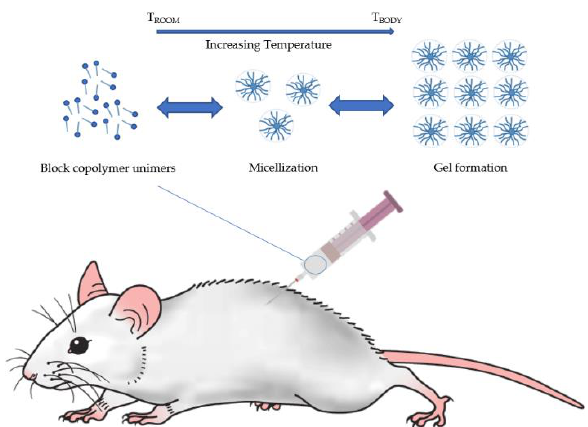
Figure 2. Schematic illustration of the in situ gelation mechanism of a thermo-responsive P407 aqueous solution. Upon a temperature rise, a breakage of the hydrogen bond is established between the aqueous solvent and the copolymer hydrophilic chains. Desolvation induces the hydrophobic interaction among the POP blocks, the formation of spherical micelles and, successively, the gelation process.